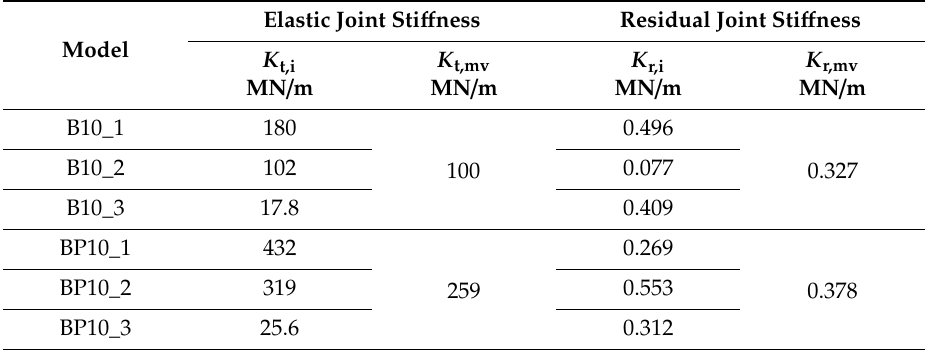
Table 11. Test results for reinforced joints (sti ff